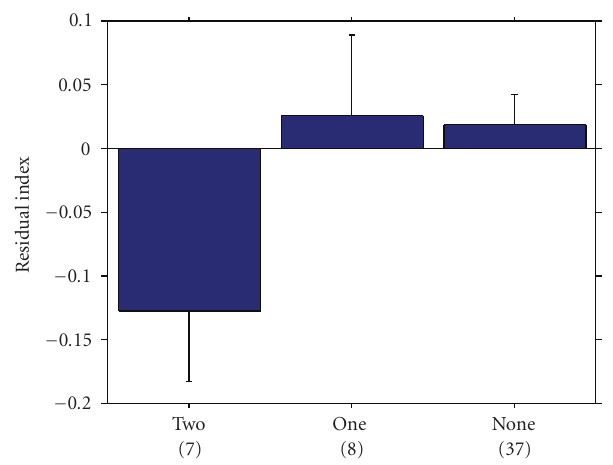
Figure 2: Means ( ± SE) of the residual index for field-collected Peucetia viridans females grouped by combinations of paracymbial processes in their epigyna. Combinations are defined in the text and the number of spiders in each group is indicated in parentheses.